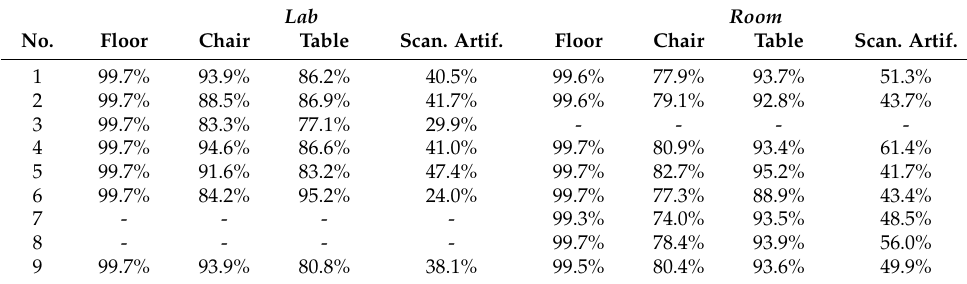
Table A5. Precision for the datasets Lab and Room , semantically segmented by PCCTI . Lab Room No. Chair Table Scan. Artif. Floor Chair Scan. Artif.